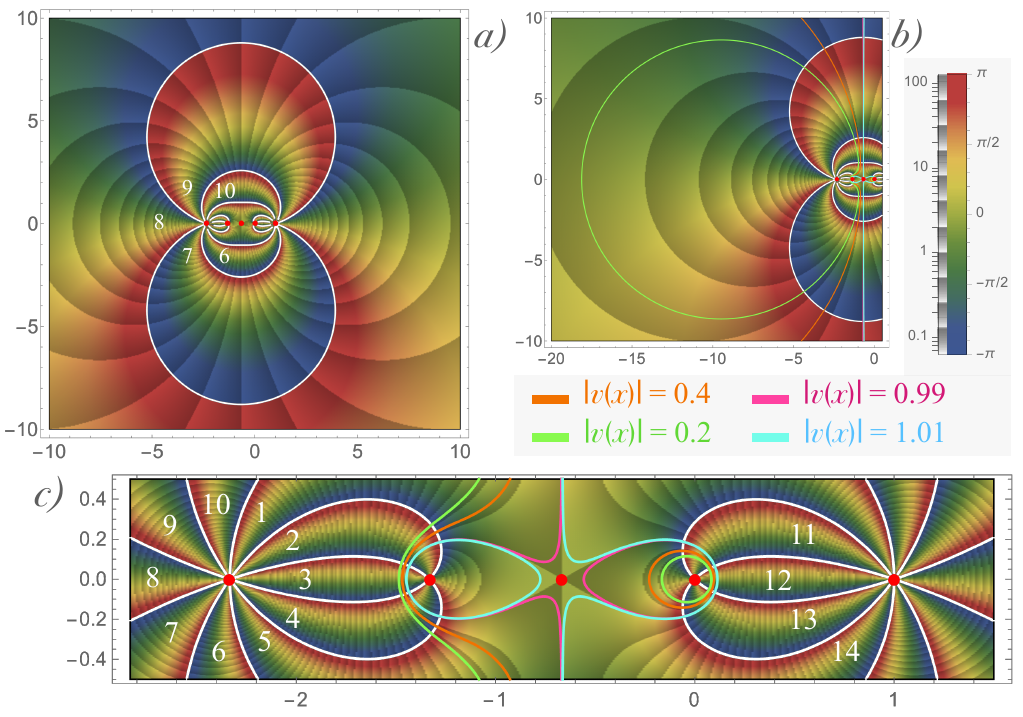
Figure 4 . Plot of v ( x ) for n 1 = 7 , n 2 = 3 . The frames’ horizontal and vertical axes are Re( x ) , and Im( x ) , respectively. Colors depict the phase of v ( x ) , and shading follows the curves of constant | v ( x ) | , as indicated by the scales. a) Complete borders of the Hurwitz regions, with “outer” regions labeled. b-c) Four contours with | v ( x ) | = constant . c) Close up of the inner region near the critical points x = − n 1 , x = − n 1 − n 2 , x = − n 1 − n 2 , x = 0 , x = 1 (red dots from left to right, n 2 n 2 2 n 2